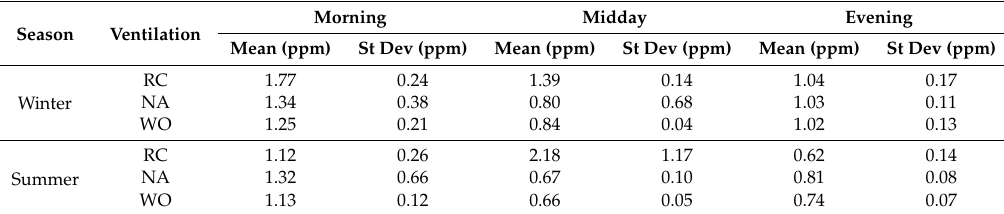
Table 3. Descriptive statistics. The arithmetic means and standard deviations (St Dev) are based on the loop averages ( n = 3) for a time of day, season, and ventilation